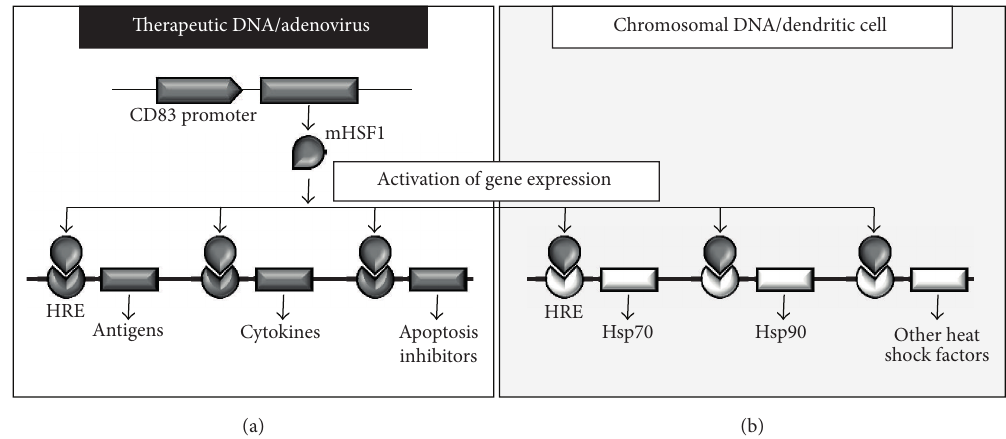
Figure 1: Schematic representation of the therapeutic DNA/adenovirus strategy and the effects of mHSF1 overexpression on endogenous heat shock response elements. (a) A constitutively active mutant heat shock factor 1 (mHSF1) will be expressed under the control of the human mDC-specific CD83 promoter. In turn mHSF1 binds to short heat shock response elements (HRE) of a second vector-encoded DNA driving expression of therapeutic transgenes (e.g., antigens, cytokines, or apoptosis inhibitors). (b) By overexpressing mHSF1 in the target cell, also endogenous HRE will become activated resulting in the expression of different heat shock proteins (Hsp), such as Hsp70 or Hsp90.